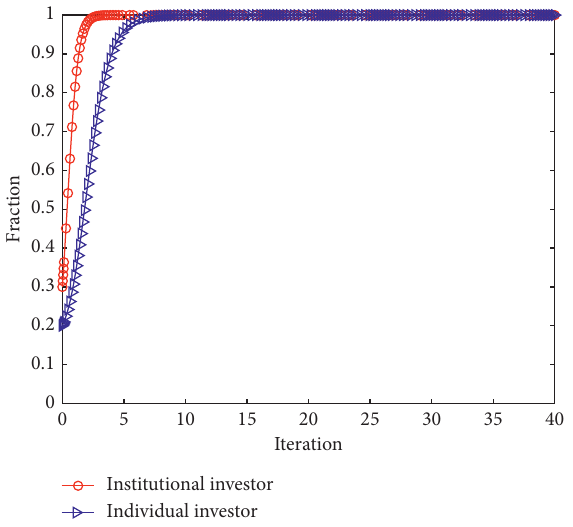
Figure 4: Simulation results for institutional and individual in- vestors using parameters R M � 3, C M � 1, R and δ � 0 . 6.